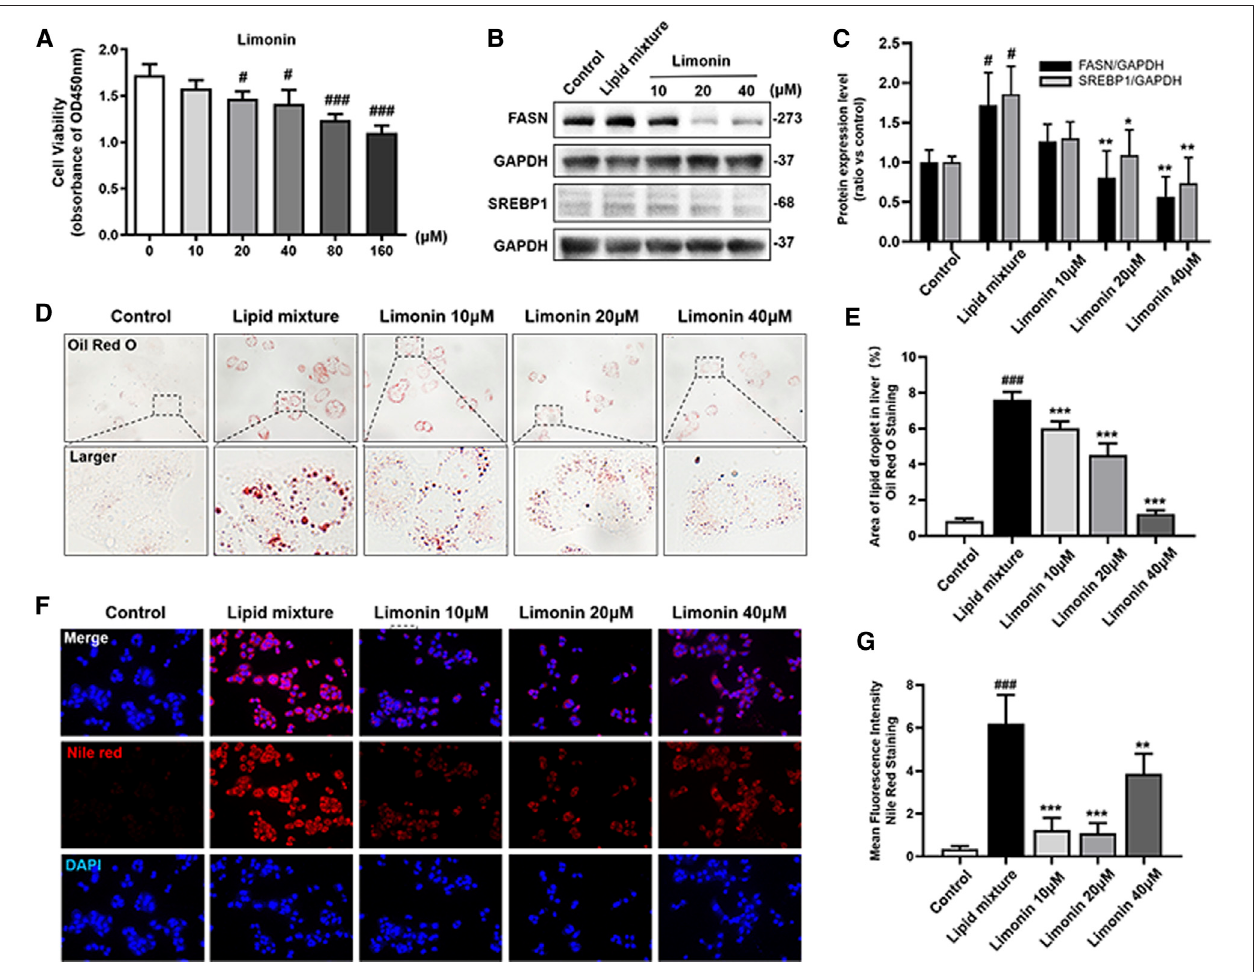
FIGURE5| Limoninreducedlipidaccumulation inLO2cellsstimulated bylipidmixture. (A) LO2cellsviabilitydetection (OD450 nmabsorbance)( n (cid:1) 4per group). (B) Western blot analysis of the expression of FASN and SREBP1. GAPDH was used as an internal control. (C) Relative quantitative protein expression of FASN and SREBP1. (D) LO2cellsoilredOstaining.Figuresaremagni fi edas × 400. (E) QuantitativeanalysisoftheareaoflipiddropletsbasedonOilRedOstaininginLO2cells. (F) NileredstainingofLO2cells.Figuresaremagni fi edas × 200. (G) Quantitativeanalysisofthemean fl uorescenceintensityofNileRed.Dataareshownasthemean ± SD from three independent experiments. # p < 0.05, ## p < 0.01, ### p < 0.001 vs control group; * p < 0.05, ** p < 0.01, *** p < 0.001 vs TAA group.